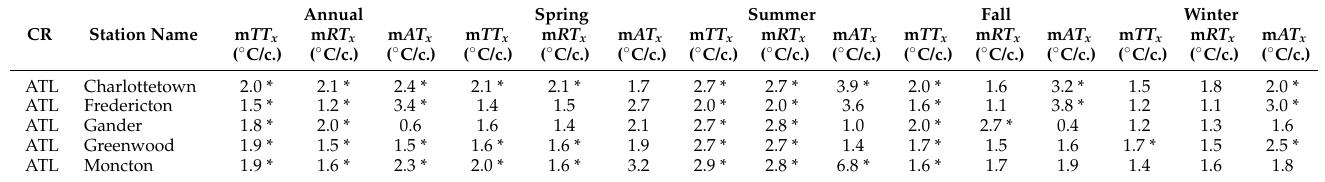
Table 5. Temperature Maxima Slopes reported in degrees Celsius per century ( ◦ C/c.) “m” represents “slope”. m TT x —Slope of Total Temperature Maximum, m RT x —Slope of Radiative Temperature Maximum, and m AT x —Slope of Advective Temperature Maximum. “CR” represents “climate re- gion”. ATL—Atlantic Canada, GRL—Great Lakes/St. Lawrence Lowlands,